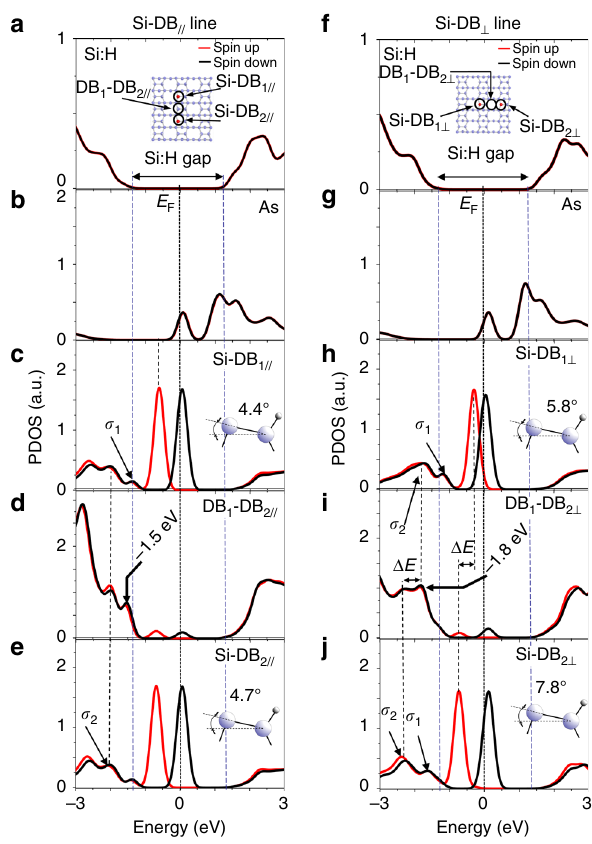
Fig. 2 Numerical analysis of the Si-DB electronic structure. a – e PDOS curve series calculated on the Si – H bond, the As atom, the Si-DB 1 , the Si – H bond in between the Si-DBs and the Si-DB 2 positions of the Si-DB // , respectively. f – j PDOS curve series calculated with the same sequence as in a for the Si- DB ⊥ . The positions of the involved atoms are indicated in the inset of a and f . The blue and white balls of the silicon slab insets are Si and H atoms, respectively. The Si atoms having a Si-DB are represented in red. Note that the position of the As atom is not indicated in the inset in a or f as it is located far from the Si-DB (see Supplementary Fig. 11 for more details). The red and black curves describe the spin-up and spin-down density of state,